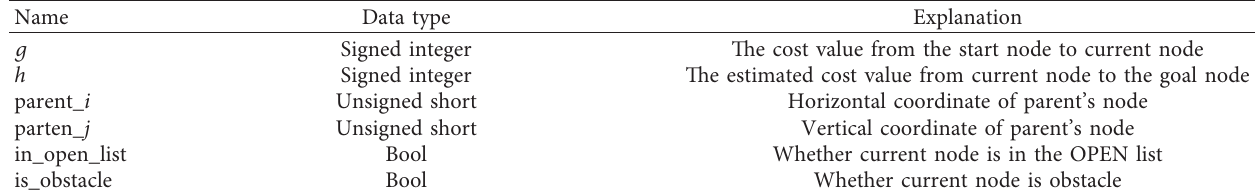
Table 1: Design of the data structure.